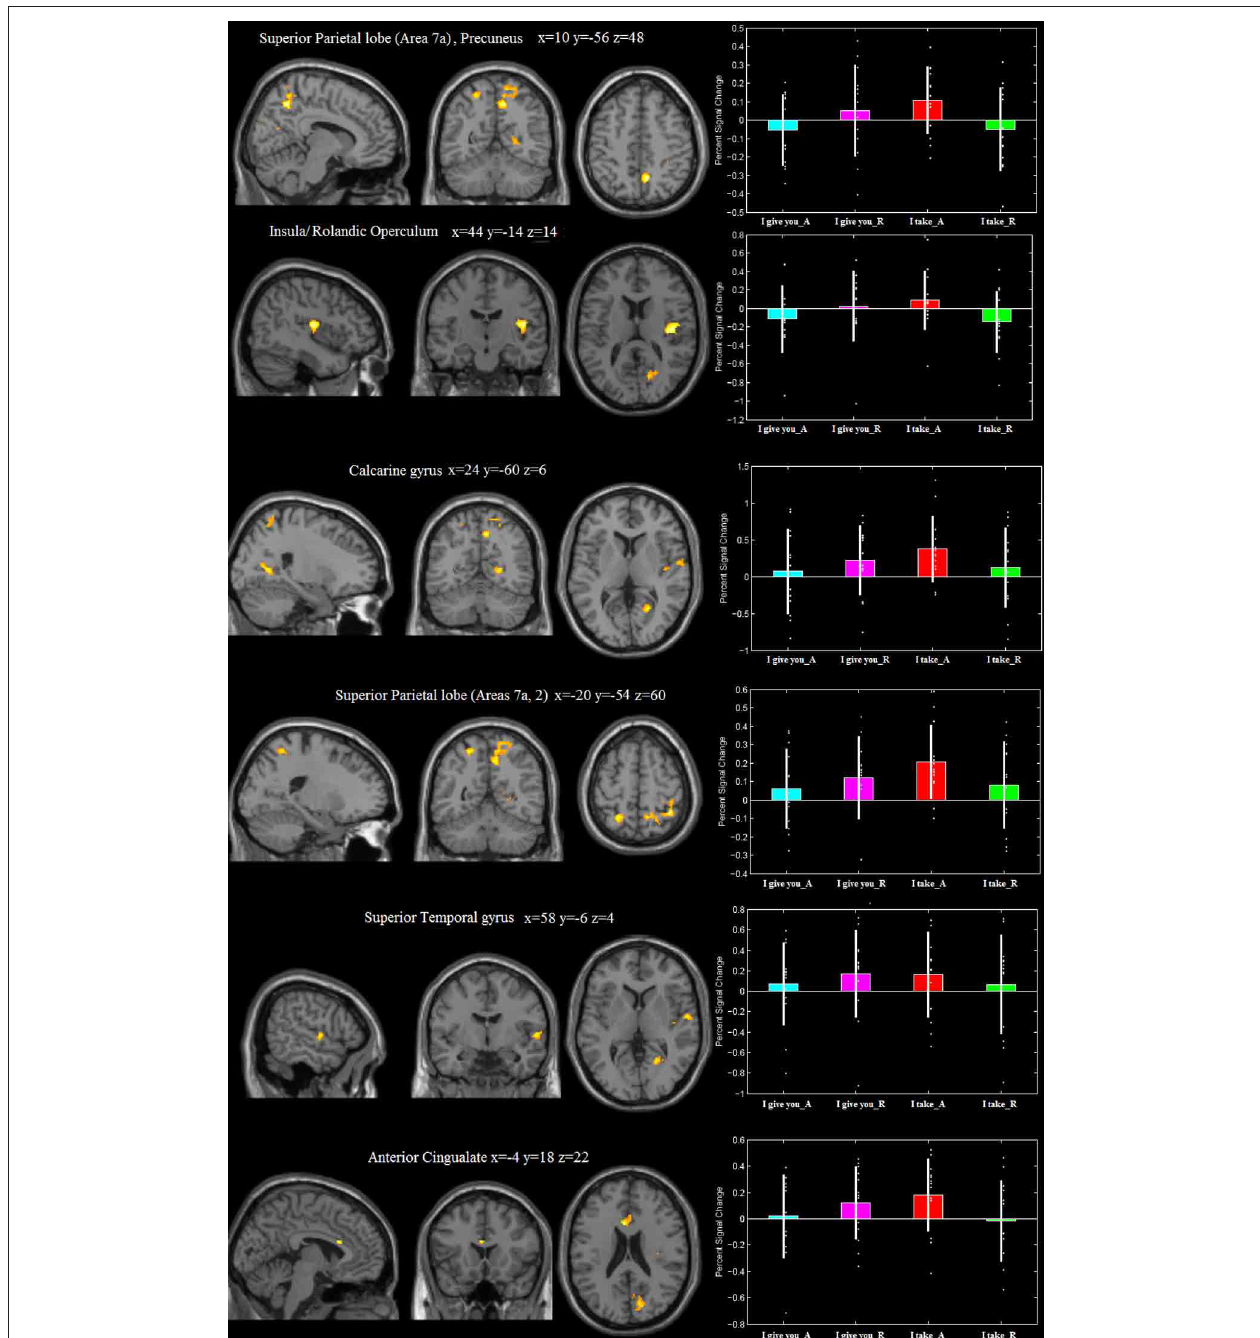
FIGURE 3 | Areas differentially recruited by the frame × type of response interaction [(“I take”_Accept > “I take”_Reject) > (“I give you”_Accept > “I give you”_Reject)]. Group mean